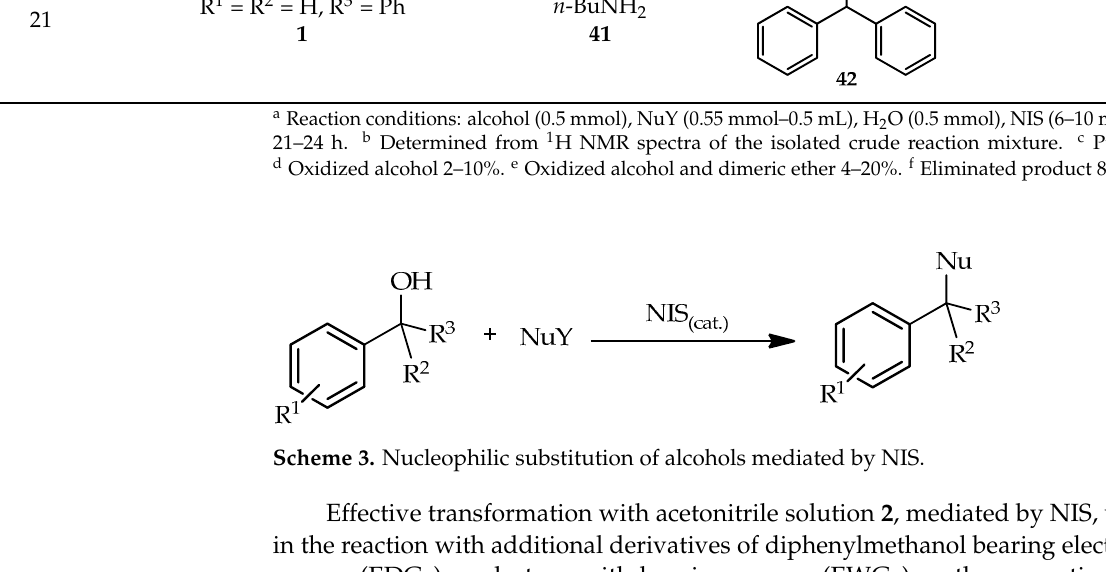
Table 2. Nucleophilic substitution of alcohols using NIS as a precatalyst a